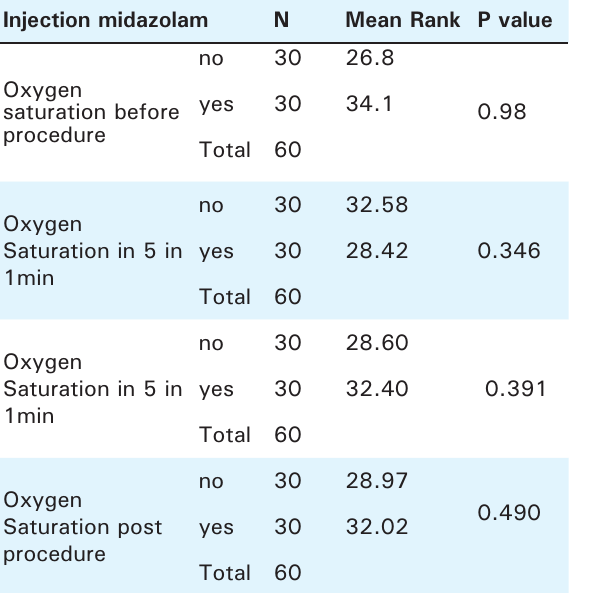
Table 3. Changes in systolic blood pressure during procedure